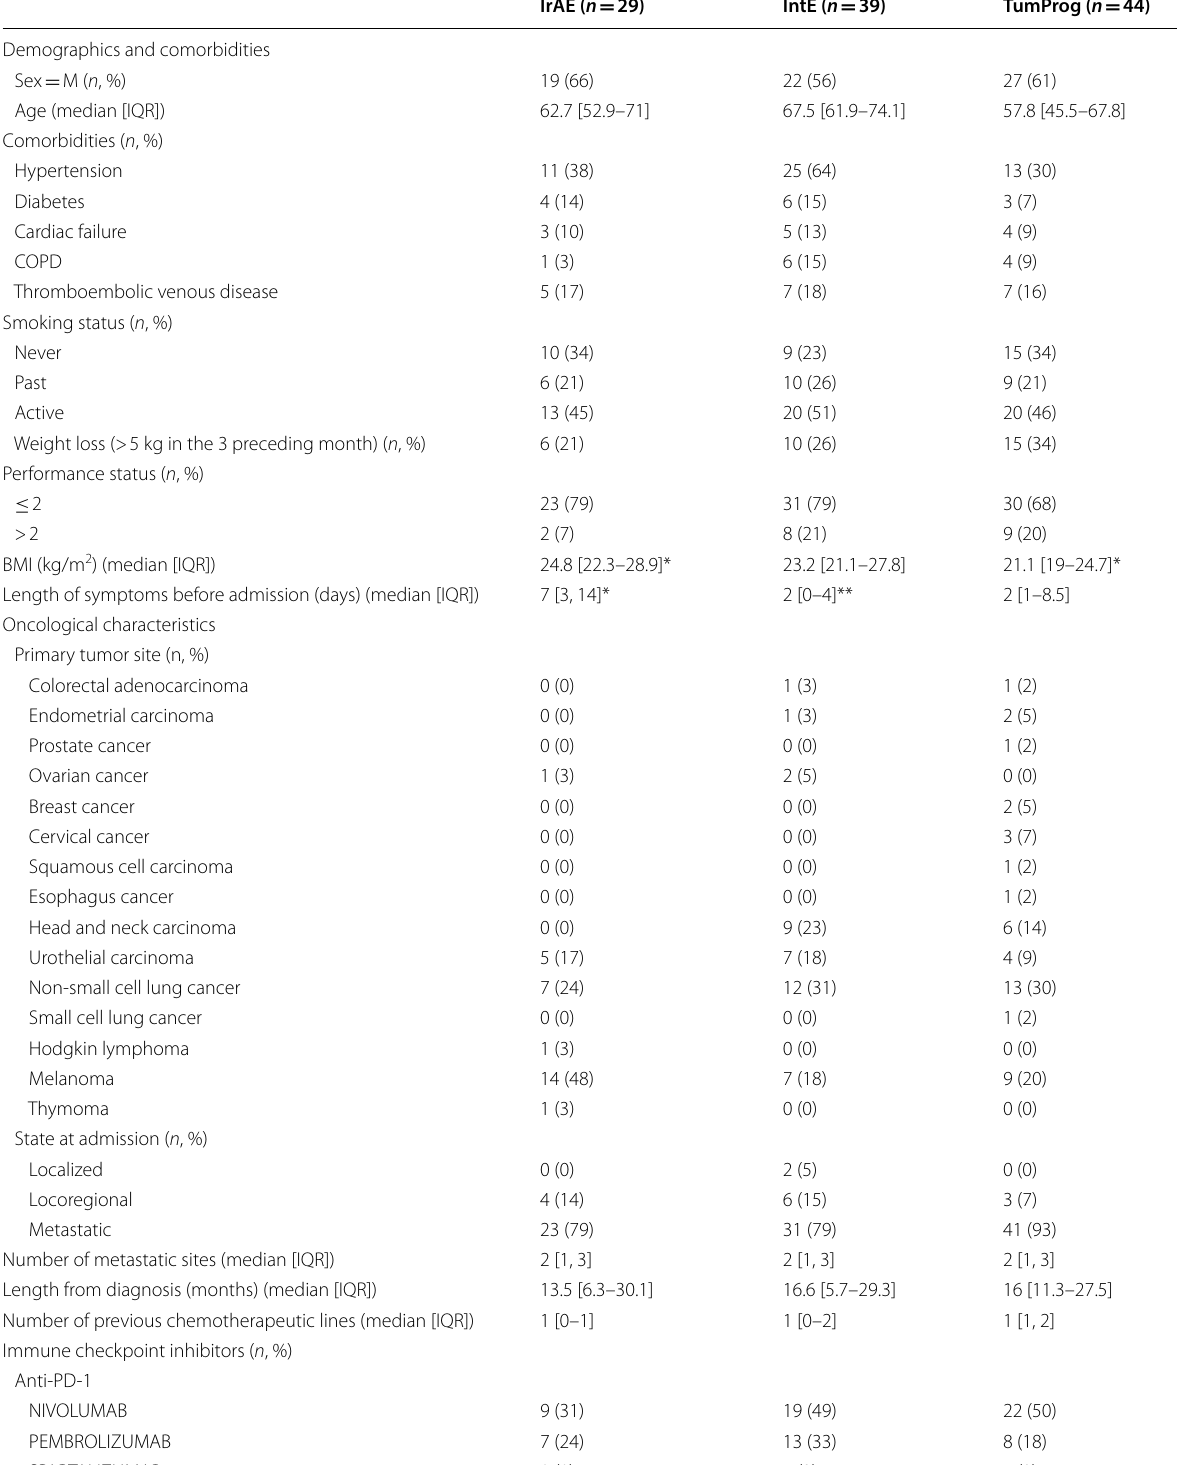
Table 1 Comparison of immune-related adverse events, intercurrent events and complications of tumor progression